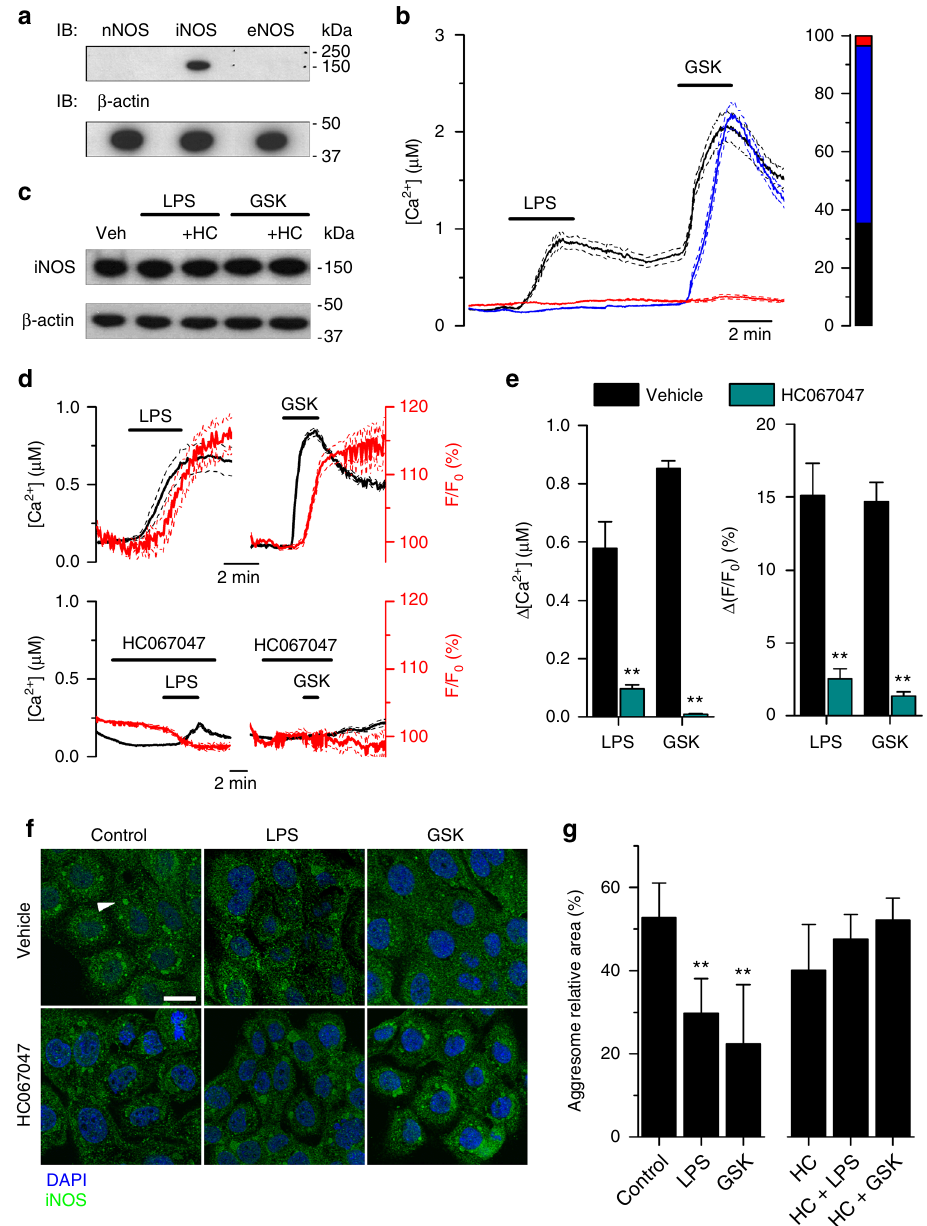
Fig. 5 TRPV4 activation by LPS triggers NO production in human bronchial EC. a Immunoblotting of 16HBE cells lysate probed for NOS isoforms. b Left, average intracellular Ca 2+ responses of human bronchial epithelial cells to 20 μ g ml − 1 LPS and 10 nM GSK1016790A. The black, blue, and red solid traces correspond to data means of cells responding to LPS and GSK1016790A, GSK1016790A alone or to none of the stimuli, respectively. The thin dashed traces represent the means ± standard errors. Right, stack bar graph showing the percentages of cells responding to LPS and/or GSK1016790A (color- coded as the graph on the left; n = 116). c Immunoblotting of 16HBE cells lysate incubated in LPS (20 μ g ml − 1 ) or GSK1016790A (10 nM). Where indicated, cells were previously incubated with vehicle (Veh, 0.8% DMSO) or the TRPV4 inhibitor HC067047 (+HC, 10 μ M). d Average intracellular Ca 2+ signals (black solid traces) and normalized fl uorescence of the NO-sensitive dye DAF-FM (F/F 0 , red solid traces) recorded in 16HBE cells ( n = 52). The thin dashed traces represent the means ± standard errors. LPS, 20 µ g ml − 1 ; HC067047, 10 µ M; GSK1016790A, 10 nM. e Average changes in intracellular Ca 2+ (left panel) and NO production (right panel) induced by LPS. The dark cyan bars correspond to cells pre-incubated with the TRPV4 inhibitor HC067047 (10 µ M). n > 74 per bar; ** P < 0.01, two-tailed t -test. f Confocal microscopy images of 16HBE cells immunostained for iNOS. The arrow head points to an aggresome structure. Scale bar, 20 μ m. g iNOS aggresomes were quanti fi ed using a custom-designed software. The graph shows the area of aggresomes relative to the total green-stained area determined from images recorded from preparations fi xed in control condition or 5 min after application of 20 μ g ml − 1 LPS or 10 nM GSK1016790A. The panel on the right corresponds to cells pre-incubated with HC067047 (HC, 10 μ M). Three randomly selected fi elds per condition were used for quanti fi cation. ** P ≤ 0.01, Dunn ’ s multiple comparison